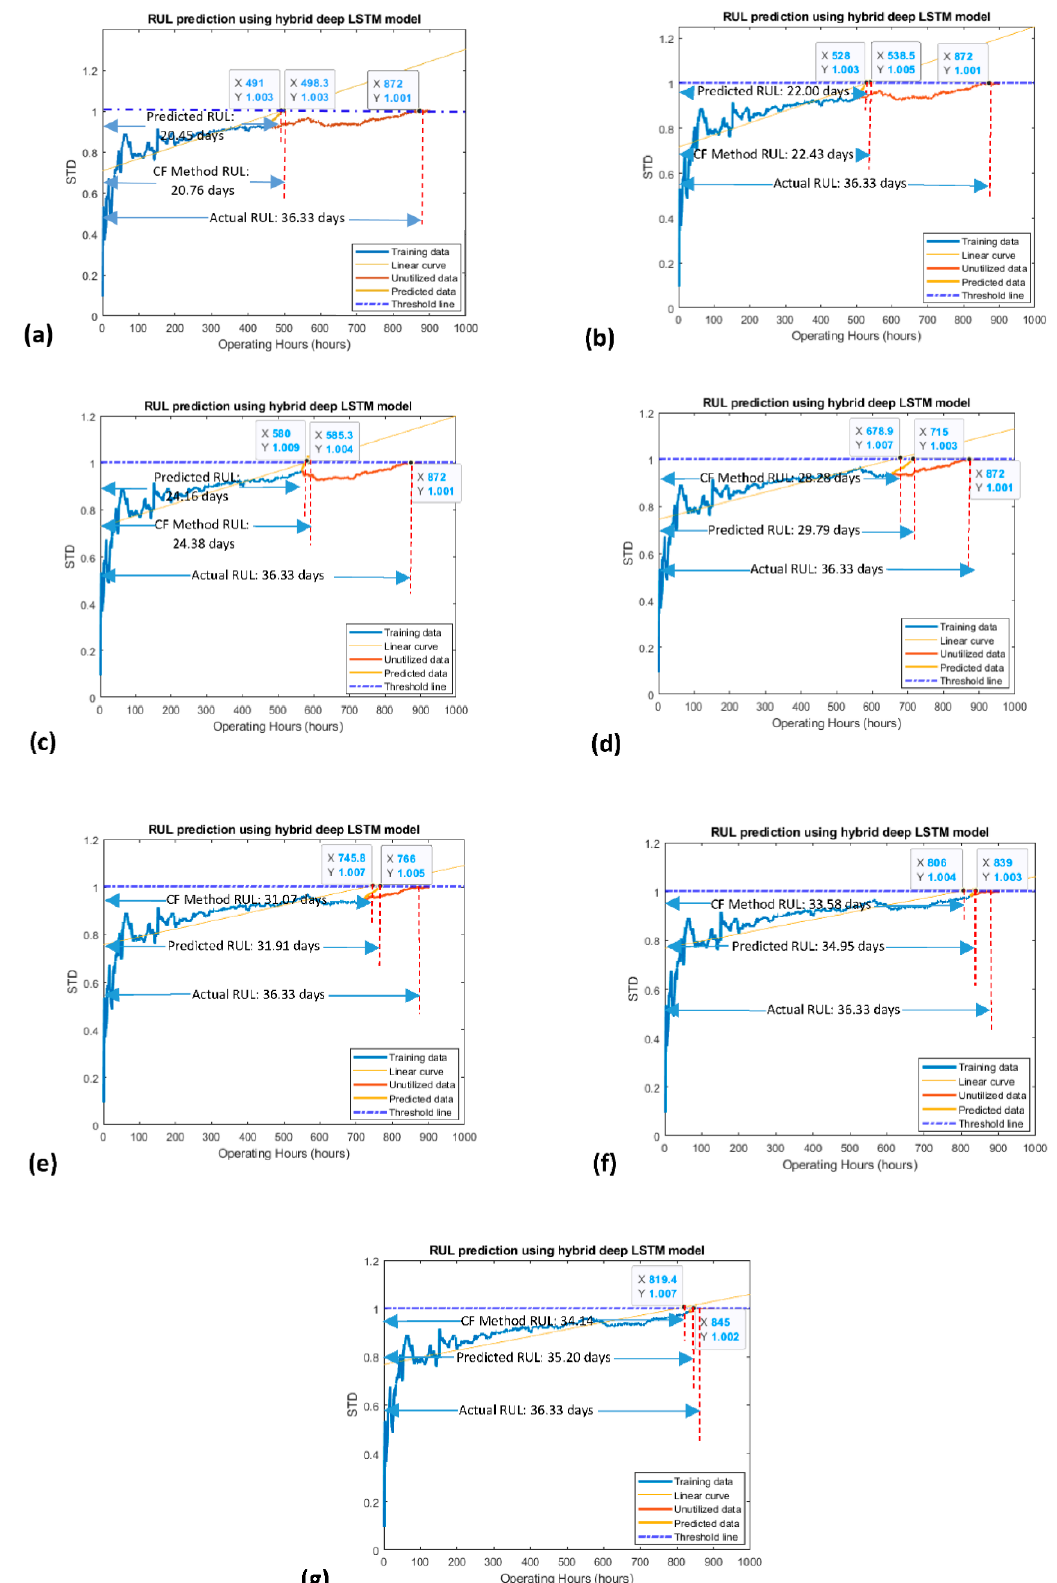
Figure 9. Online RUL prediction results, obtained by the curve-fitting and proposed methods for channel 4, ( a – g